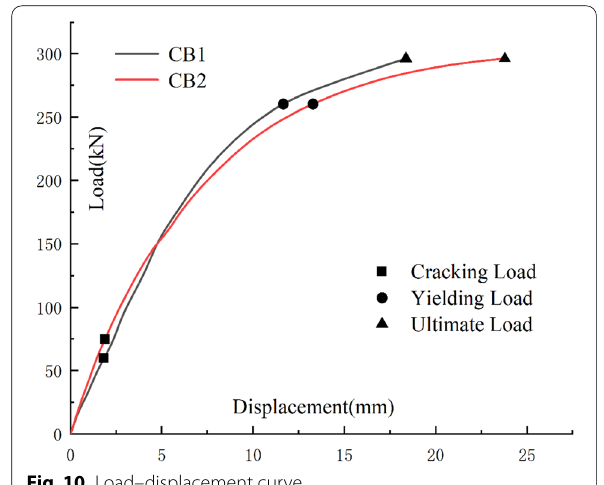
Fig. 10 Load–displacement